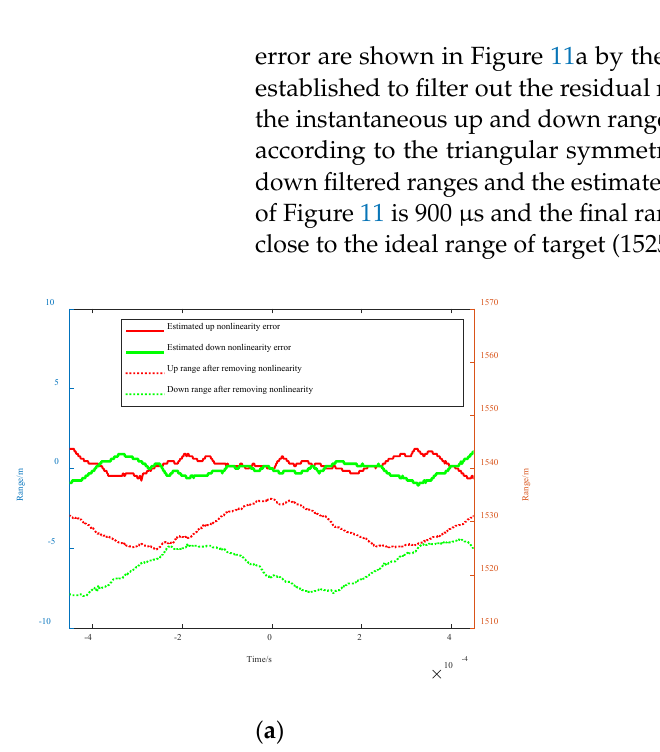
Figure 11. ( a ) The estimated nonlinearity errors (shown by the left axis) and the preliminarily compensation results of the instantaneous measurement ranges (shown by the right axis); ( b ) The filtered ranges and the estimated range of target.